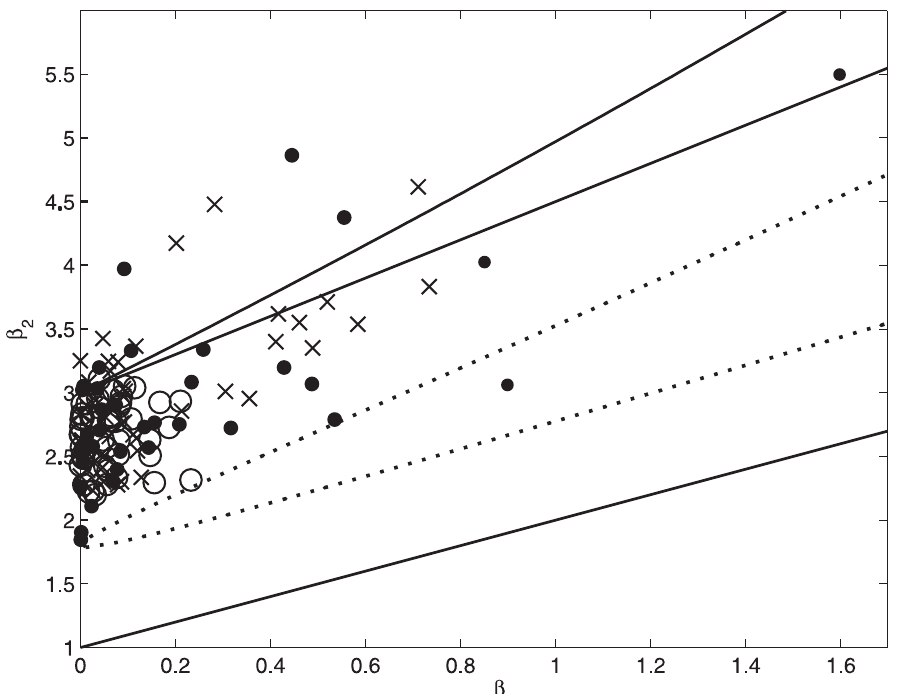
Fig. 4. The (cid:12) plane (cid:12)lled by results of several simulations. Probability distribution of wave packet amplitudes, log( A 2 ): P I ( (cid:22); (cid:27) 2 ; (cid:12) 1 ; (cid:12) 2 ). Symbols: circles { P I ( (cid:22) = (cid:0) 7 ; (cid:27) 2 = i 1 : 7 2 ; (cid:12) 1 = 0 : 4 ; (cid:12) 2 = 2 : 5); (cid:2) { P I ( (cid:22) = (cid:0) 0 : 5 ; (cid:27) 2 = 0 : 5 2 ; (cid:12) 1 = 0 : 4 ; (cid:12) 2 = 2 : 5), black dots { 36 WIND events.